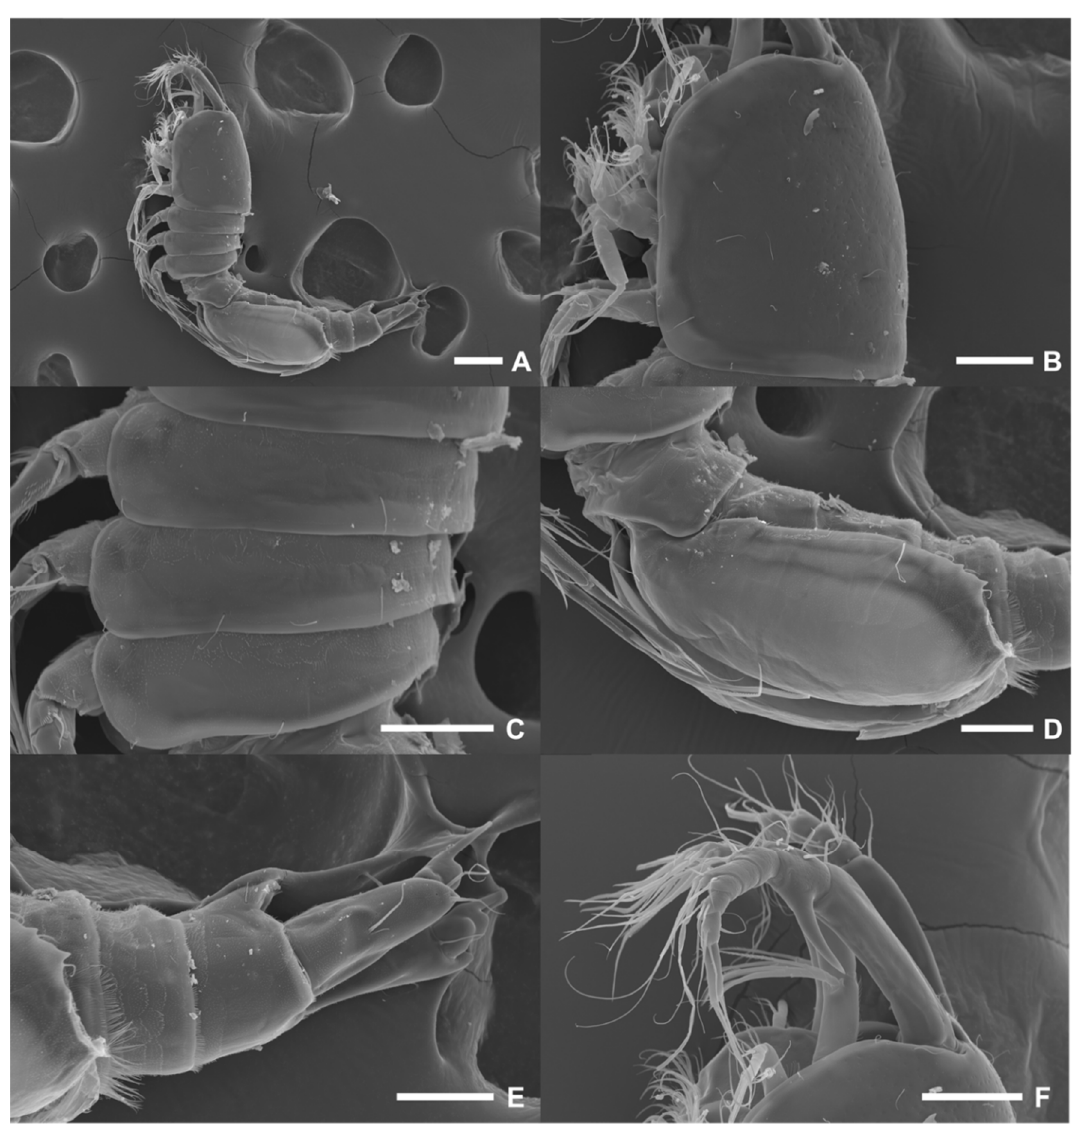
Figure 4. Scanning electron microscopy images of Phyllopodopsyllus saywakimi sp. nov. female (paratype 3) in lateral view: ( A ) habitus; ( B ) cephalothorax; ( C ) second to fourth prosomites; ( D ) first to third urosomites and P5; ( E ) fourth and fifth urosomites, and caudal rami; ( F ) antennule and antenna. Scale bars: ( A ) 100 µm; ( B – F ) 50 µm.